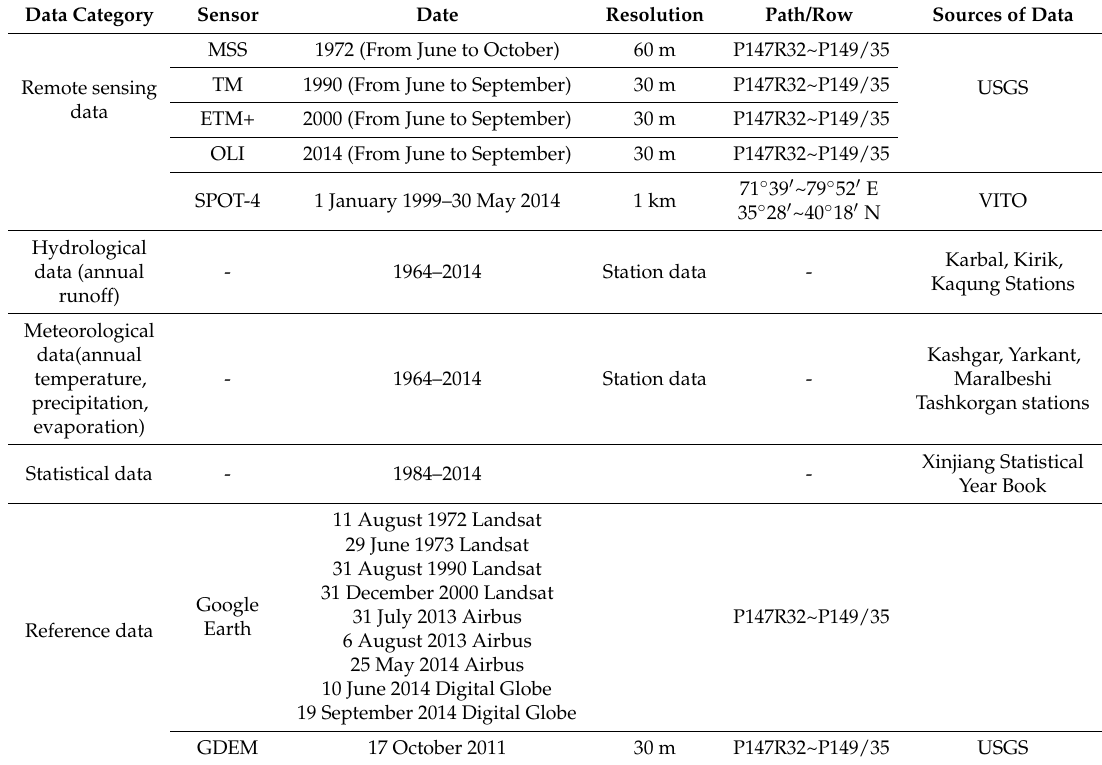
Table 1. Datasets used in this